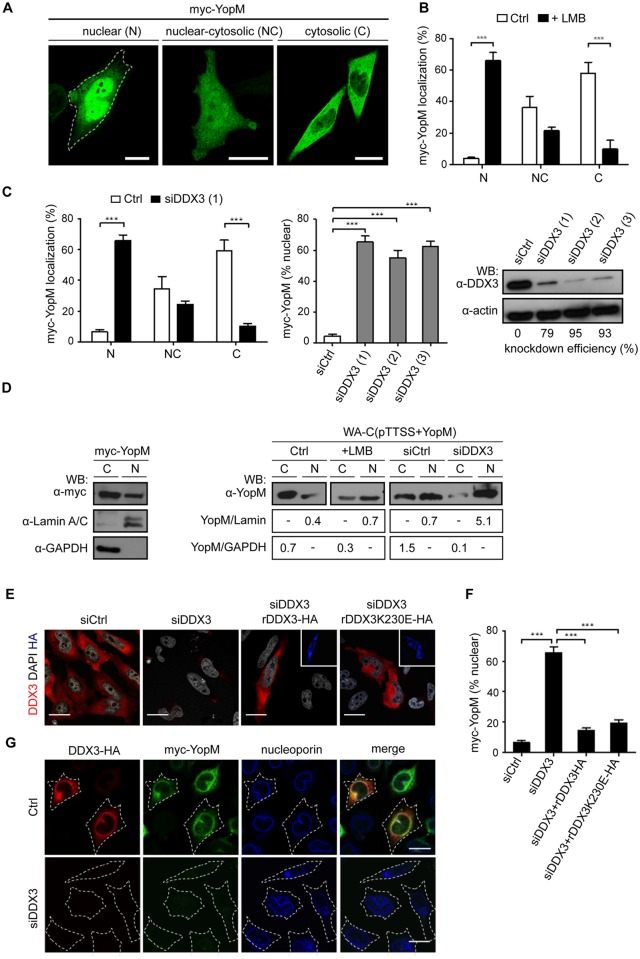
DDX3 mediates nuclear export of YopM via the CRM1 pathway.
A) Defining three patterns of nuclear/cytosolic distribution of YopM. HeLa cells expressing myc-YopM were immunofluorescence stained using anti-myc antibody and a nuclear (N), nuclear/cytosolic (NC) and cytosolic (C) distribution pattern of YopM was identified. Scale bar, 20μm. B) CRM1 inhibitor Leptomycin B increases percentage of nuclear localized YopM. HeLa cells expressing myc-YopM were not treated (Ctrl) or treated with 25 nM LMB for 4 h and then anti-myc immunofluorescence stained. The percentage of cells showing a N-, NC- or C localization of myc-YopM was determined. Each bar represents mean ± SED of 100 cells from three different experiments; ***p<0.001. For distribution of DDX3 within cells under LMB treatment see S3 Fig. C) Knockdown of DDX3 increases percentage of nuclear localized YopM. HeLa cells were treated with control siRNA (siCtrl) or DDX3 siRNA (siDDX3 No. 1, 2 or 3 as indicated) for 48 h, transfected with a vector encoding myc-YopM for 18 h and the percentage of cells displaying a N-, NC-, or C localization (left panel) or a N-localization (middle panel) of YopM was determined employing anti-myc immunofluorescence staining. Lysates of siRNA treated cells were analyzed by Western blot using anti-DDX3 antibody to determine knockdown efficiencies. Anti-actin antibody was used to verify equal loading of the SDS PAGE gels (right panel). Each bar represents mean ± SEM of 100 evaluated cells from 2–4 different experiments; ***p<0.001. D) Inhibition of CRM1 and knockdown of DDX3 increase the amount of YopM in nuclear cell fractions. (Left panel) Cytosolic (C) and nuclear (N) fractions of HEK293T cells expressing myc-YopM were prepared as in Methods and subjected to anti-myc immunoblot. Purity of fractions was verified using anti-GAPDH (cytosolic marker) and anti-Lamin A/C- antibody (nuclear marker), respectively. (Right panel) HEK293T cells were not treated (Ctrl) or treated with LMB, non targeting siRNA (siCtrl) or DDX3 siRNA (No. 3) and then infected with WA-C(pTTSS+YopM) for 1.5 h. Cytosolic (C) and nuclear (N) fractions of the cells were subjected to anti-YopM, anti-Lamin A/C and anti-GAPDH immunoblot. Band intensity ratios of nuclear YopM/Lamin and cytosolic YopM/GAPDH are depicted. E) Recomplementation of DDX3 knockdown cells with different DDX3 constructs. HeLa cells were treated with control siRNA (siCtrl) or DDX3 siRNA (siDDX3 No. 3) for 48 h and then transfected with vectors encoding siRNA-resistent HA-labelled DDX3 (rDDX3-HA) or the K230E mutant thereof (rDDX3K230E-HA). Cells were double immunofluorescence stained with anti-DDX3- and anti-HA antibodies and costained with DAPI for visualizing nuclei. Cells (re)expressing rDDX3 or rDDX3K230E stained positive with both, anti-DDX3- (red) and anti-HA (blue; insets) antibodies. Scale bar, 20 μm. F) Recomplementation of DDX3 reverses nuclear accumulation of YopM. HeLa cells were treated as in E) and were additionally transfected with myc-YopM and then immunofluorescence stained with anti-DDX3-, anti-HA and anti-myc antibodies. N-localized YopM was evaluated in cells either negative for DDX3 staining (siDDX3) or positive for DDX3 staining (remaining conditions). Each bar represents mean ± SEM of 100 cells from three different experiments; ***p<0.001. G) YopM and DDX3 colocalize at the outer nuclear membrane. HeLa cells were not treated (upper row) or treated with DDX3 siRNA No. 1 for 48 h (lower row) and then transfected with vectors encoding myc-YopM and DDX3-HA. Cells were permeablized with digitonin for 2 min before fixation to release the cytoplasm but leave the outer nuclear membrane intact and then stained with anti-HA- (red), anti-myc- (green) and anti-nucleoporin (blue) antibodies. Representative images are shown. Scale bar, 20 μm.